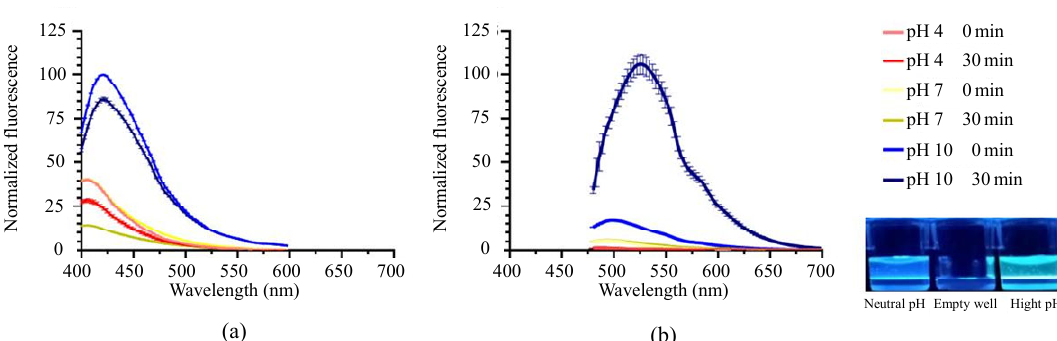
Fig. 4 Emission spectrum of ThiAKS at pH 4.0, 7.0, and 10.0: (a) excitation wavelength at 360 nm and (b) excitation wavelength at 450 nm. Data mean ±SEM experiment performed duplicate.